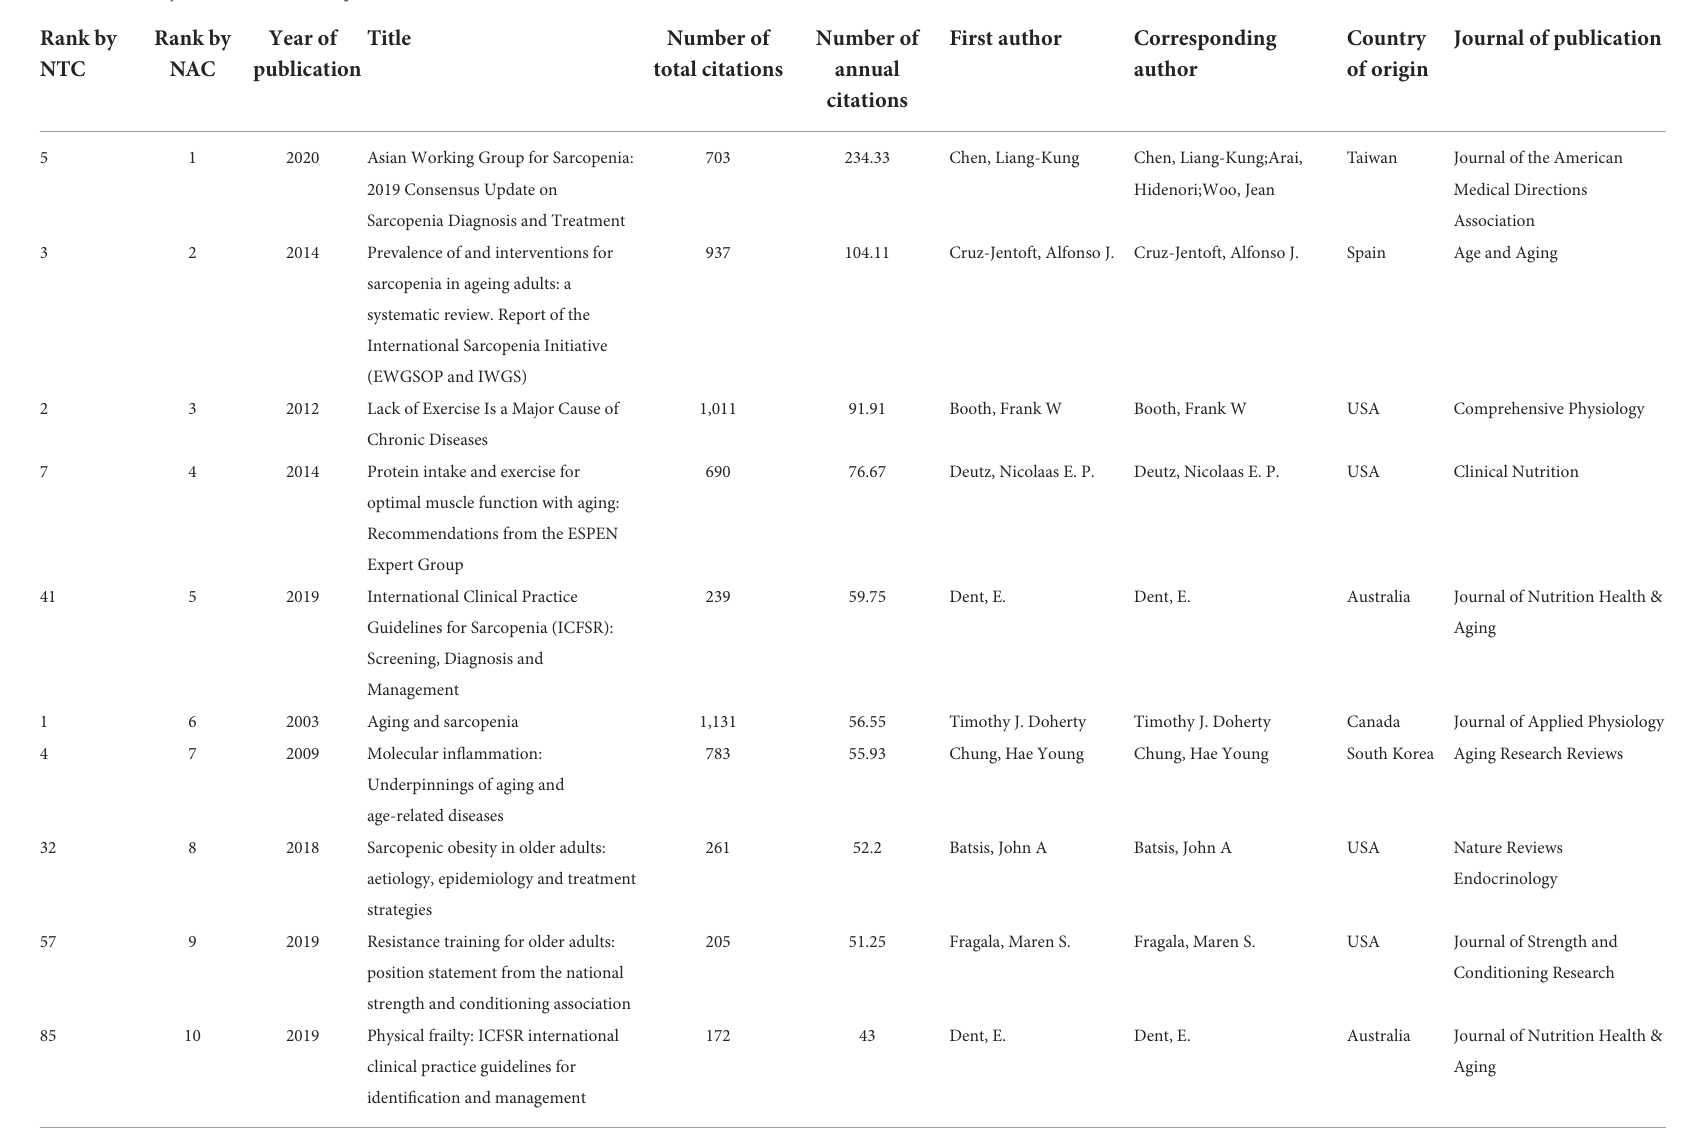
TABLE 1 The top 10 articles ranked by annual citations. Rank